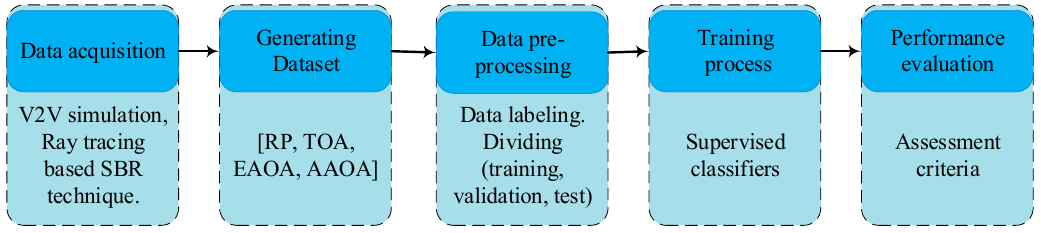
Figure 4. Stages of the supervised classi fi cation process.